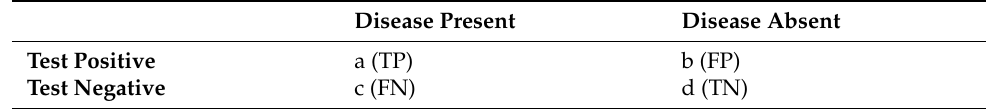
Table 2. The confusion matrix for a binary classification model. Disease